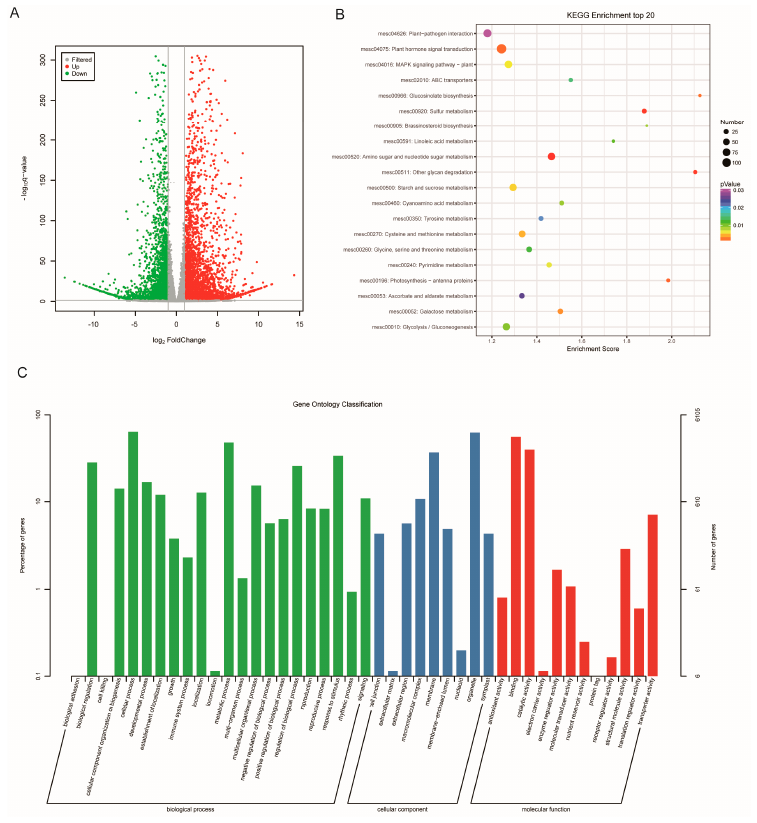
Figure 3. Screening and functional enrichment analysis of DEGs. ( A ) The overall distribution of gene expression levels and fold differences between SC and PC. ( B ) KEGG pathway enrichment of DEGs. ( C ) Gene ontology classification of DEGs. SC: M. esculenta Crantz cv. sugar cassava GPMS0991L; PC: M. esculenta Crantz cv. pink cassava BRA117315.